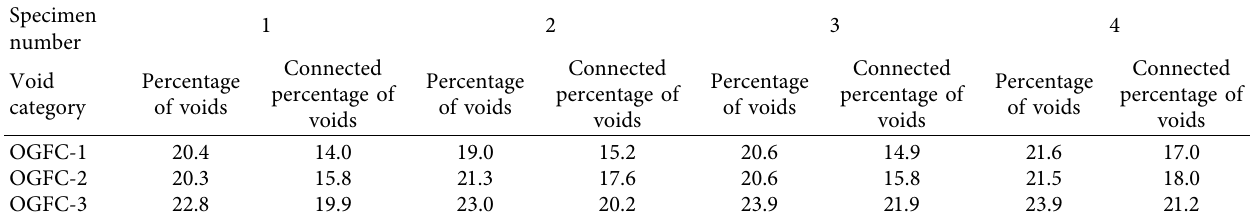
Table 6: OGFC mixture’s percentage of voids and connected percentage of voids (%).